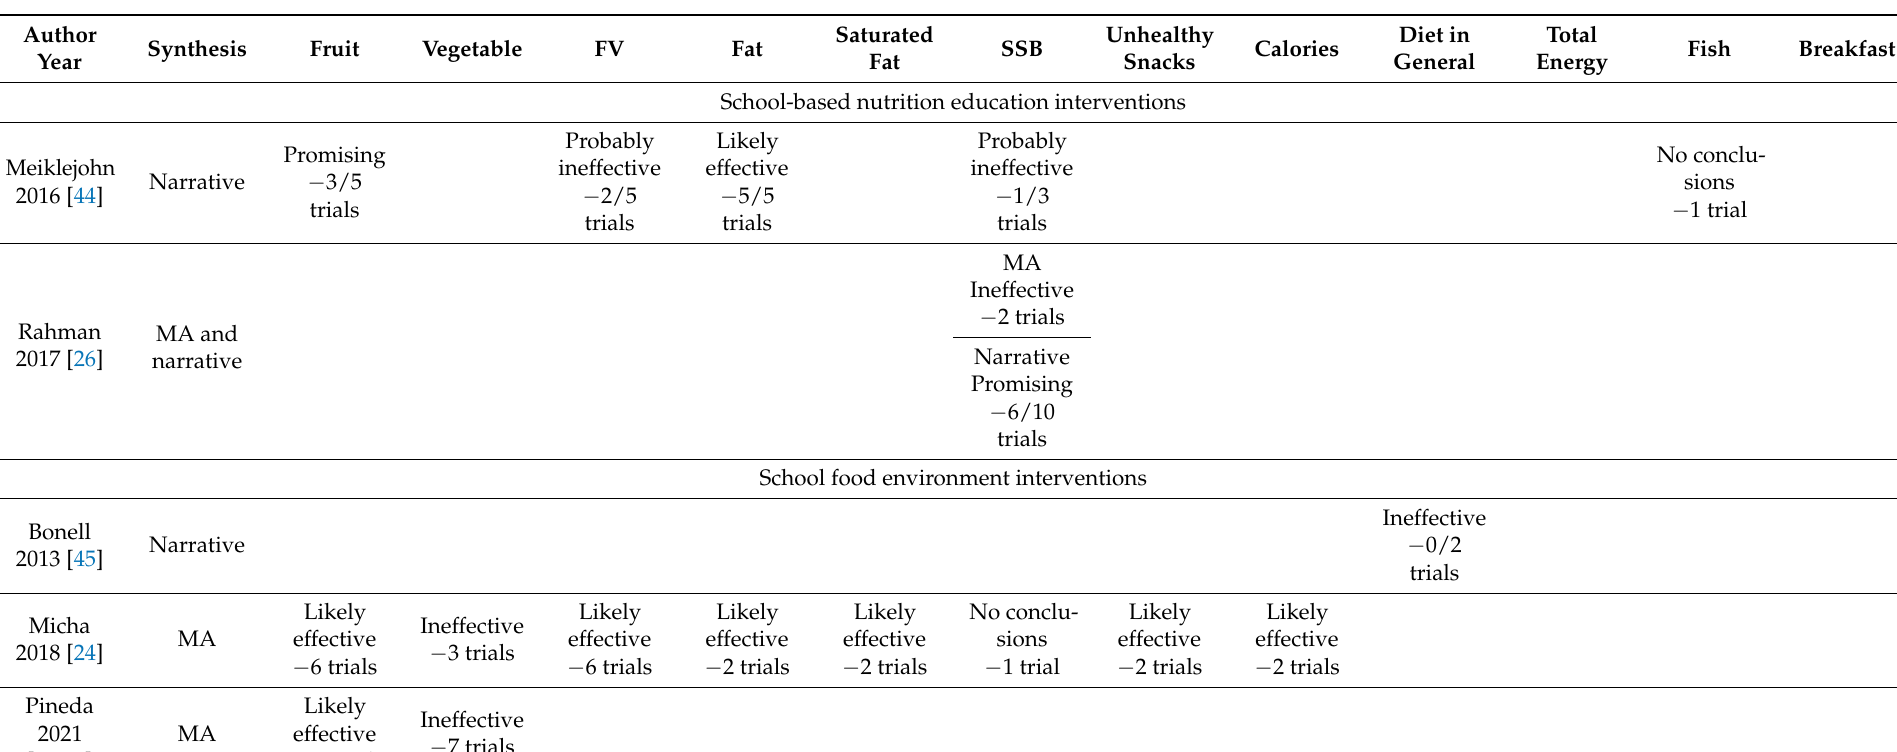
Table 2. Results of RCTs of school-based nutrition interventions compared to control according to the effectiveness categorisation framework